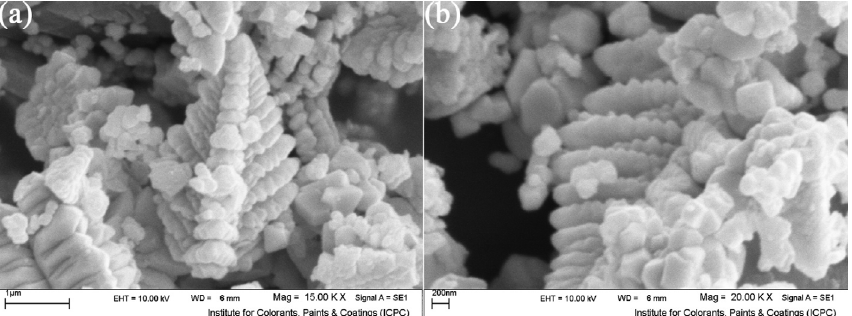
Figure 15 (a, b): SEM image of sample no. 7 with 15 KX and 20 KX magnification, respectively.